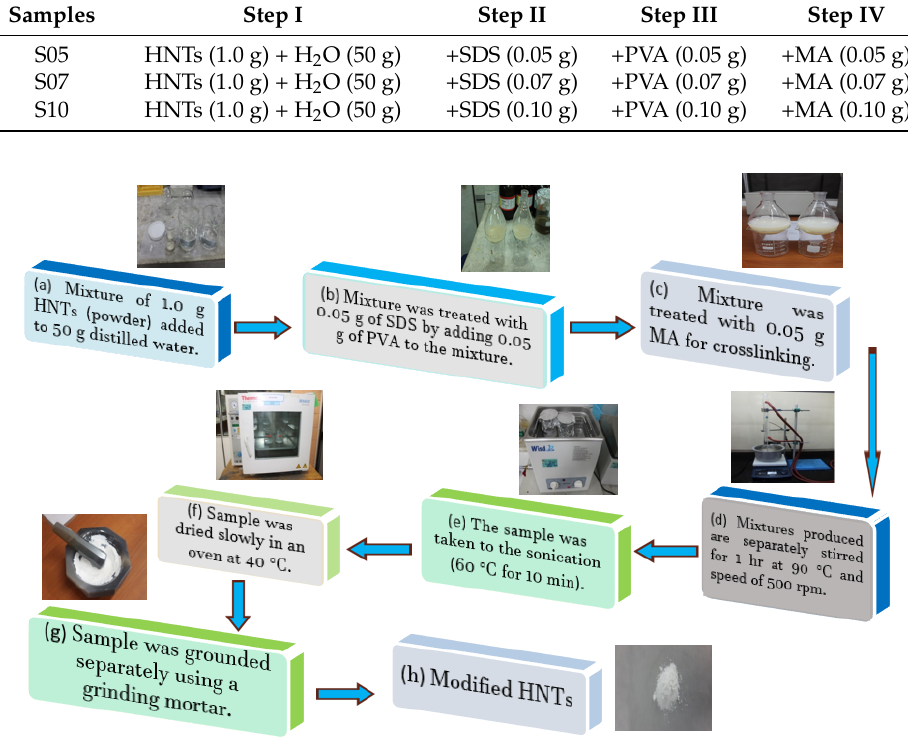
Figure 4. Procedure of crosslinked HNTs ‐ PVA nanocomposites using MA.